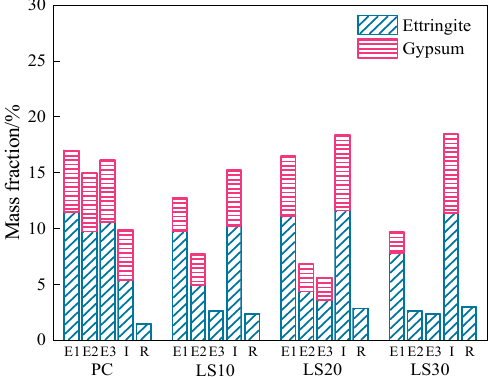
Figure 8. Mass fraction of main chemical products in each part of the specimens with different limestone content after partially immersed specimens for 80 days.